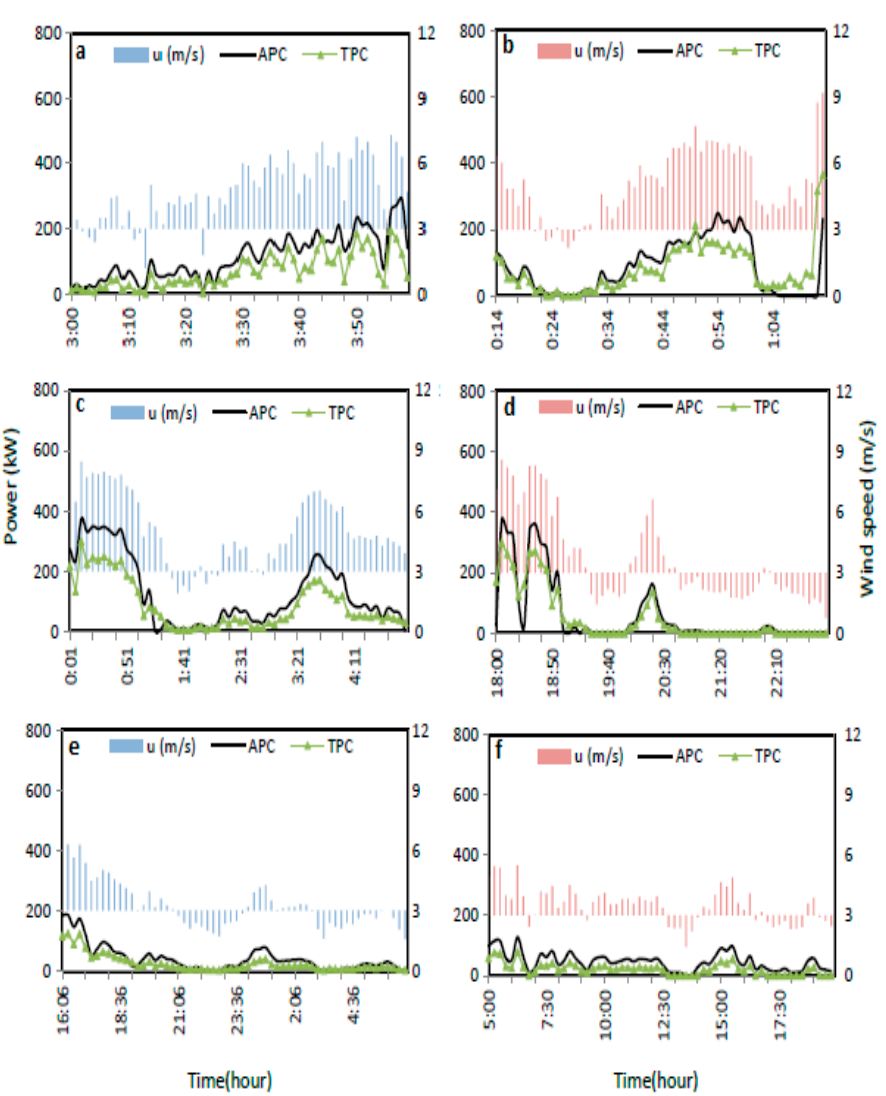
Figure 3. Turbine actual and theoretical power output during scenario C for: 1-min time intervals in ( a ) winter and ( b ) summer; 5-min time intervals in ( c ) winter and ( d ) summer; and 15-min time intervals in ( e ) winter and ( f ) summer, with average wind speed bars inset.